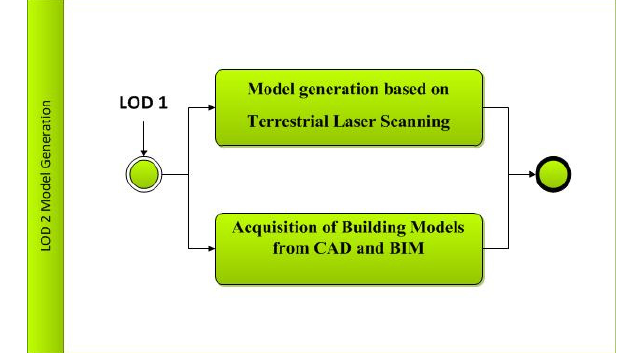
Figure 4 . LOD 2 Model generation processes